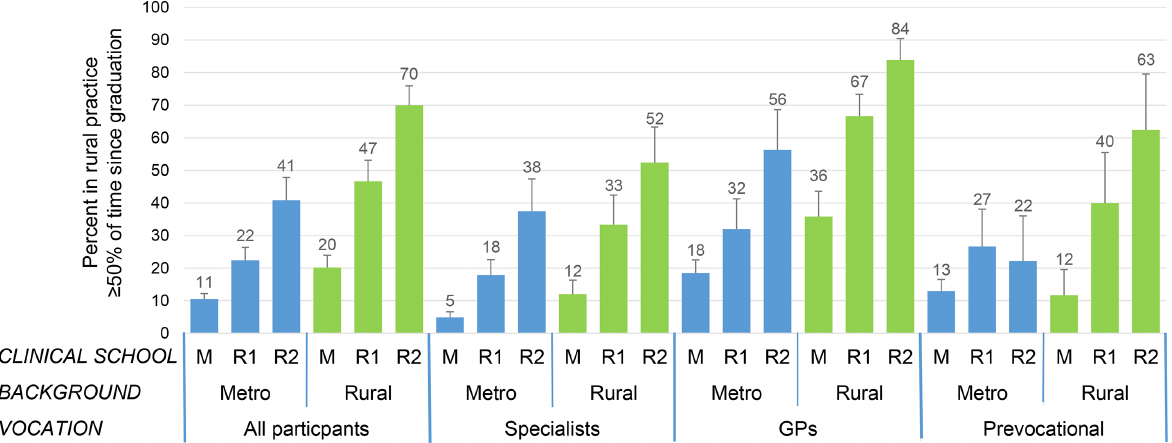
Fig 1. Proportion of graduates practicing in a rural area at least 50% of time since graduation. M, MetropolitanClinicalSchool; R1 Rural ClinicalSchool–1 year; R2 Rural ClinicalSchool–2 years; Metro, metropolitan.